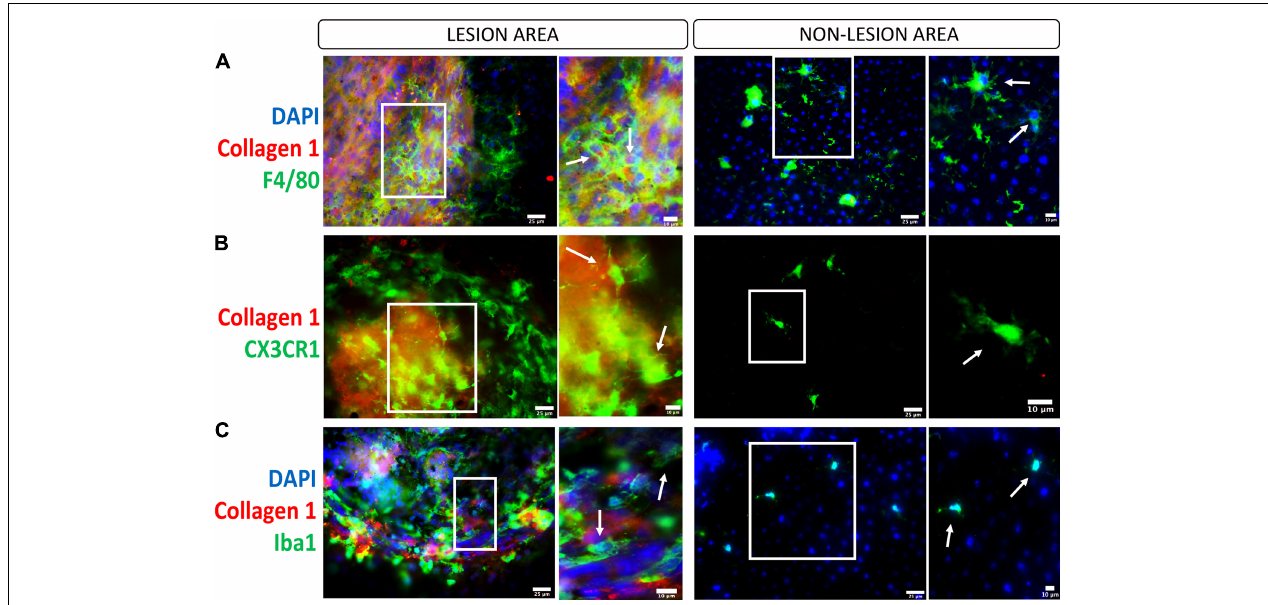
FIGURE 3 | Macrophages/microglia in the subretinal fibrotic lesion. Representative images, and their zoom-in images, of the lesion (left panel) and non-lesion (right panel) area of RPE flat mounts stained for collagen-1, DAPI and F4/80 ( A , macrophage marker), CX3CR1 ( B , microglial marker), and Iba1 ( C , marker for activated microglia and macrophages). Scale bars = 25 µ m; Zoom images Scale bars = 10 µ